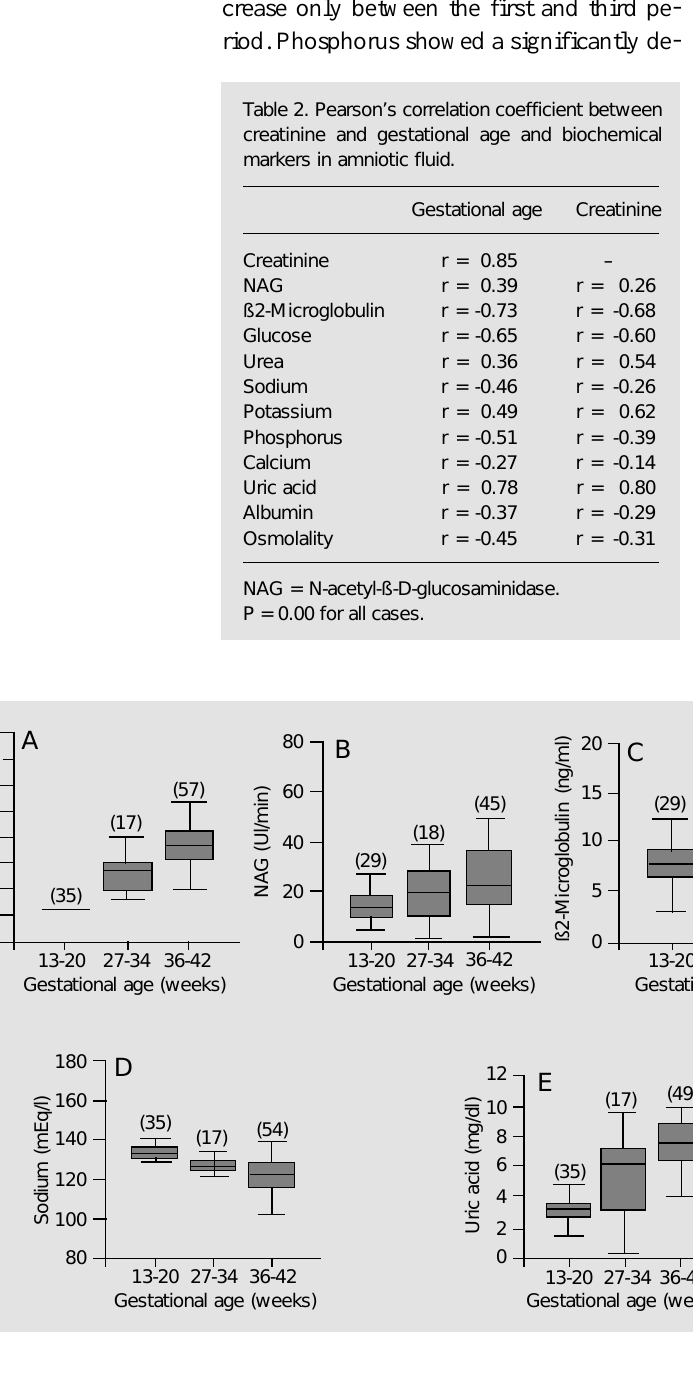
Table 2. Pearson’s correlation coefficient between creatinine and gestational age and biochemical markers in amniotic fluid.